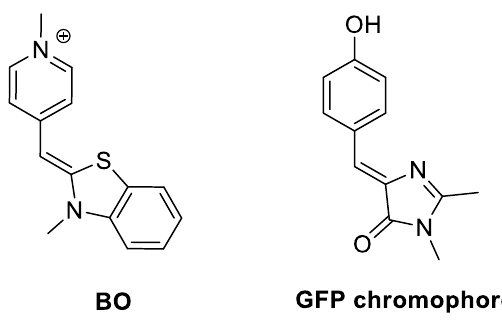
Figure 1. Structures of BO and GFP chromophore.